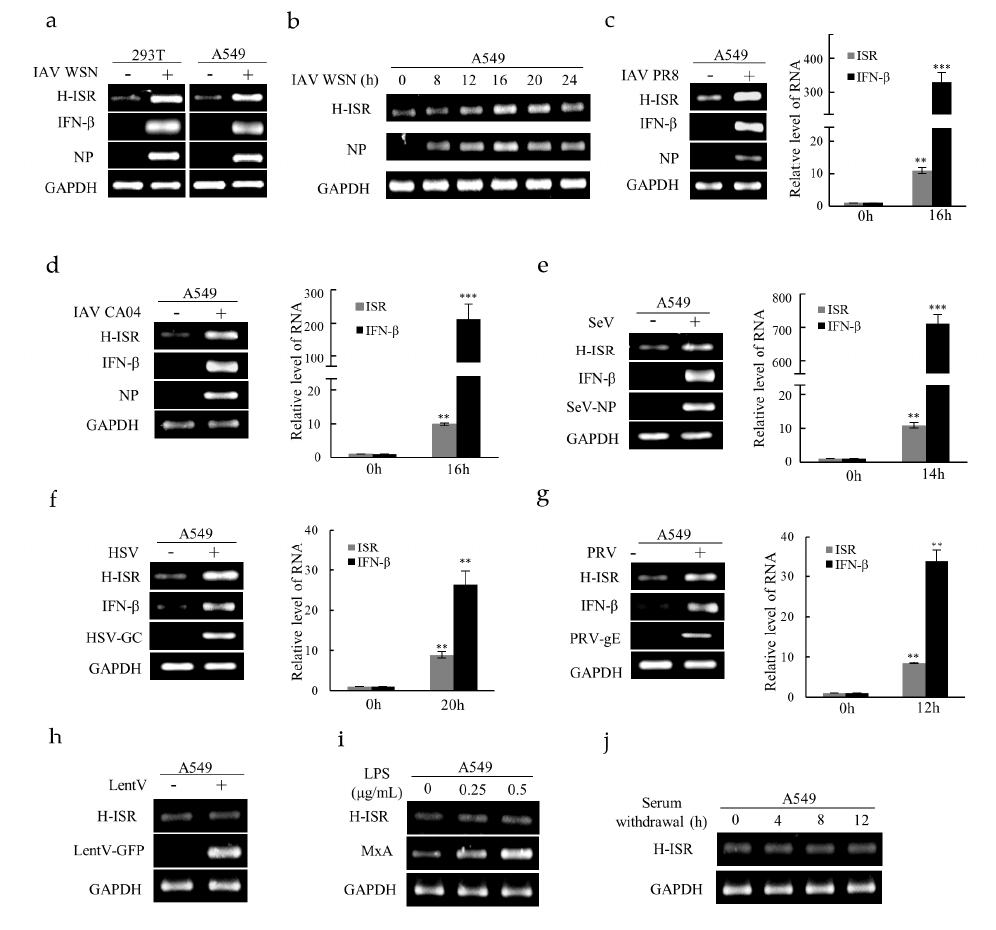
Figure 2. Human lncRNA ISR is induced by several virus infections. ( a ) The lncRNA ISR and IFN- β expression levels in indicated human cell lines infected with or without IAV WSN (MOI = 0.8) for 16